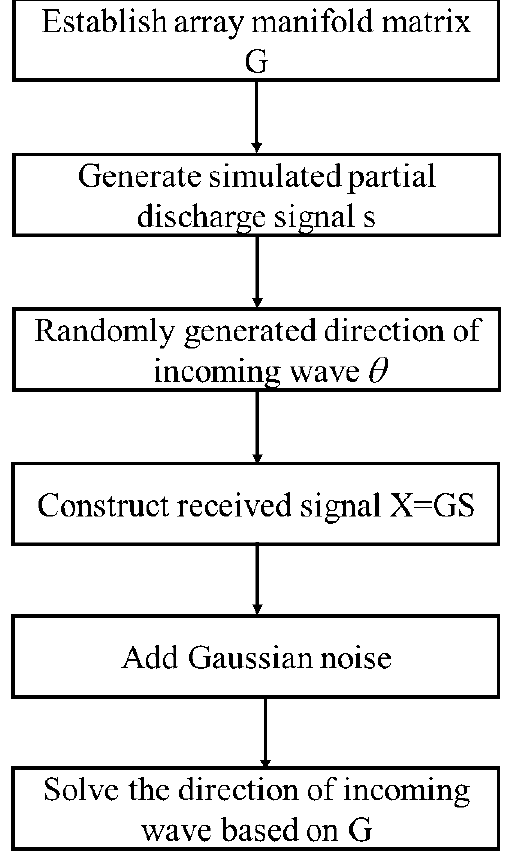
Figure 2. Simulation flowchart of